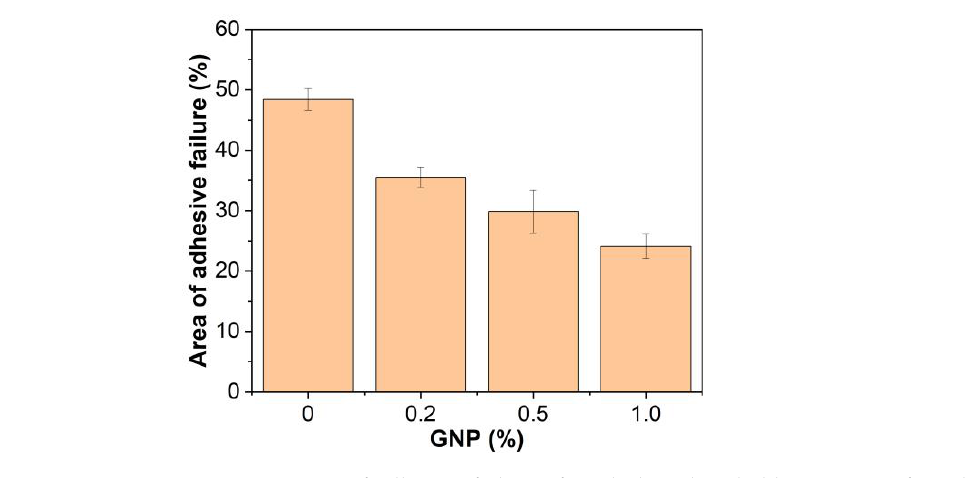
Figure 19. Area of adhesive failure of steel plates bonded by GNP-reinforced EABCs after room- temperature pull-off adhesion tests.